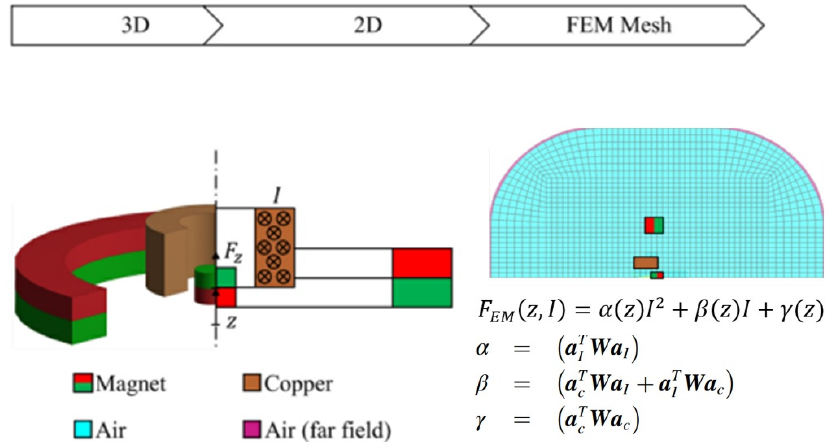
Figure 6. The catch actuator’s design. Where, a is the vector of magnetic vector potential; W is a body-dependent weighting matrix.